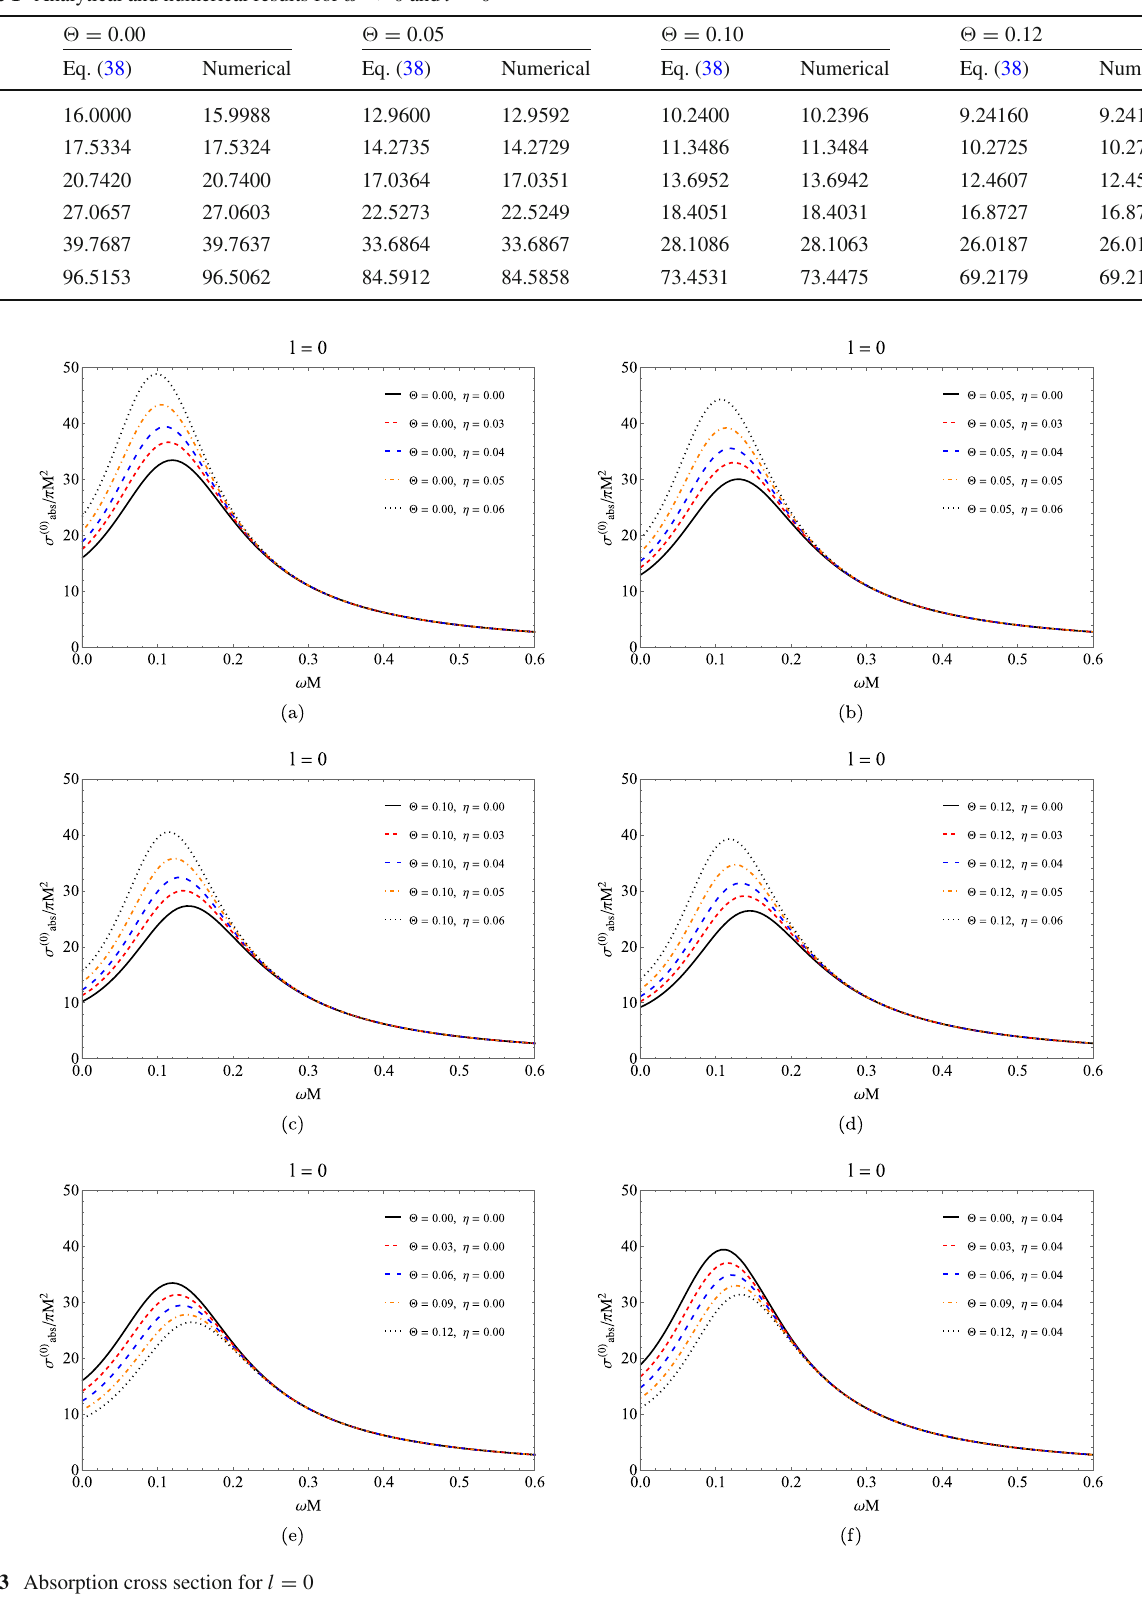
Table 1 Analytical and numerical results for ω → 0 and l = 0